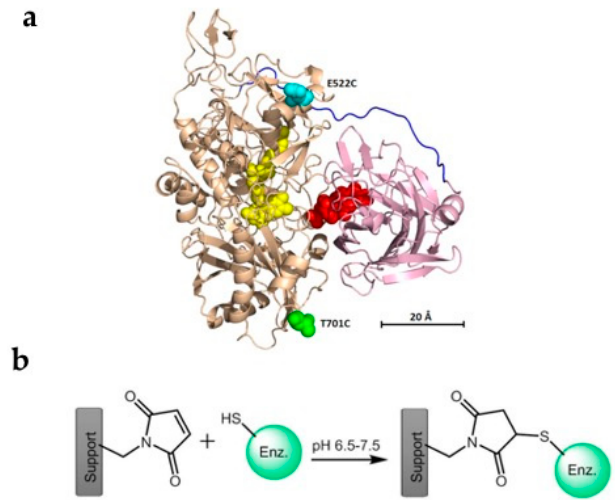
Figure 5. ( a ) Structure of Mt CDH with cysteine E522 and T701 mutations shown in blue and green, respectively; FAD and the heme group are highlighted in yellow and red, respectively. The flexible chain linking the two domains is in blue; ( b ) the maleimide group anchored on an electrode surface can react with the mutant cysteine residue in the enzyme. Reproduced with permission from [45].